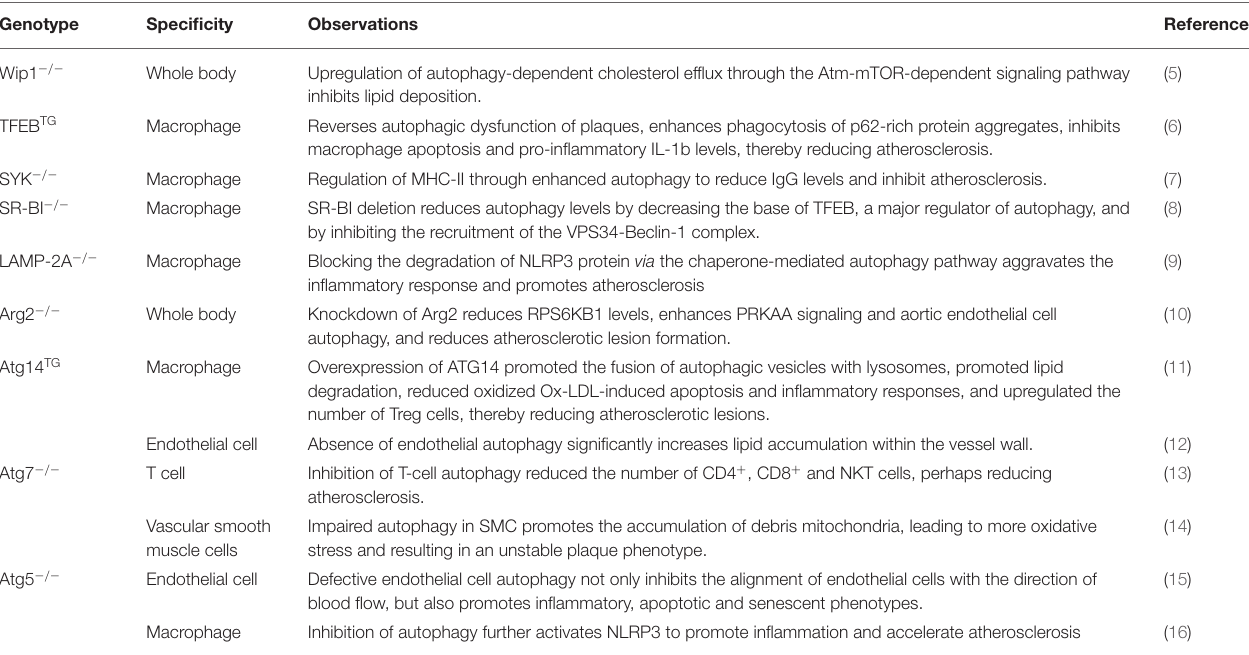
TABLE 1 | Genetic studies implicating autophagy in